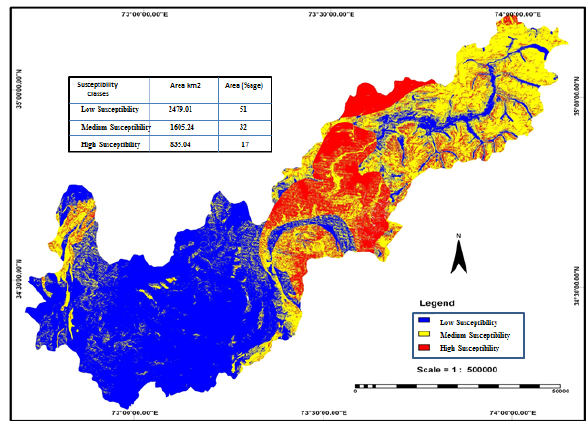
Figure 5. Landslide susceptibility